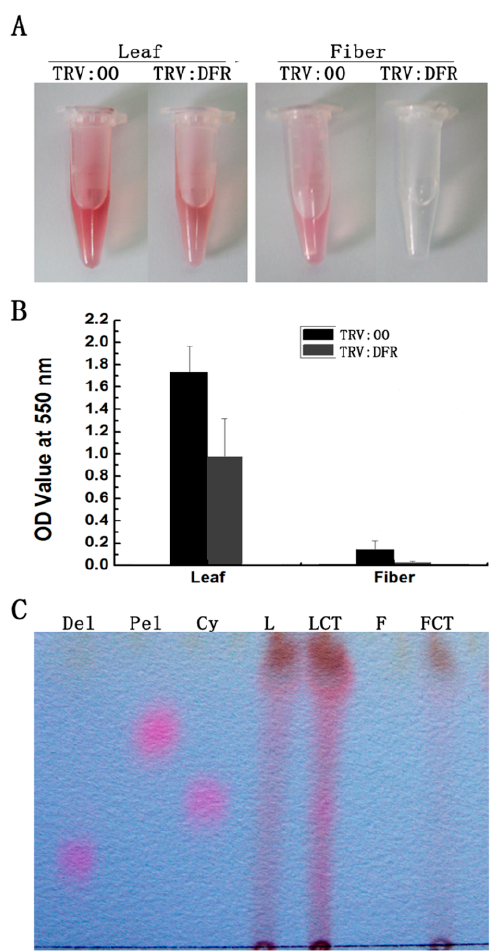
Figure 5. Comparison of PAs from GhDFR1 -silenced plants and the control. ( A ) Color intensity derived from cleavage due to the butanol:HCl boiling of PAs; ( B ) Absorbance values of anthocyanidins resulting from PA cleavage at 550 nm; ( C ) TLC profiles showing anthocyanidins intensities from butanol:HCl cleaved PAs; Cy: cyanidin; Pel: pelargonidin; Del: delphinidin.